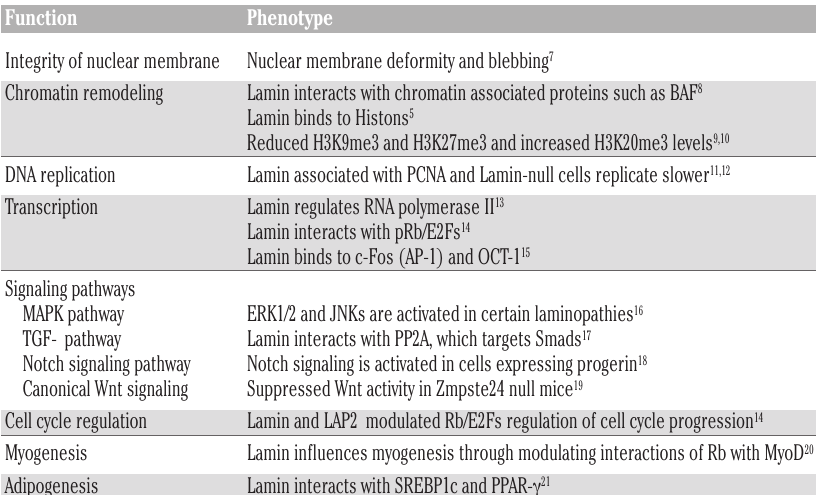
Table 1. Partial list of biological functions of LMNA .